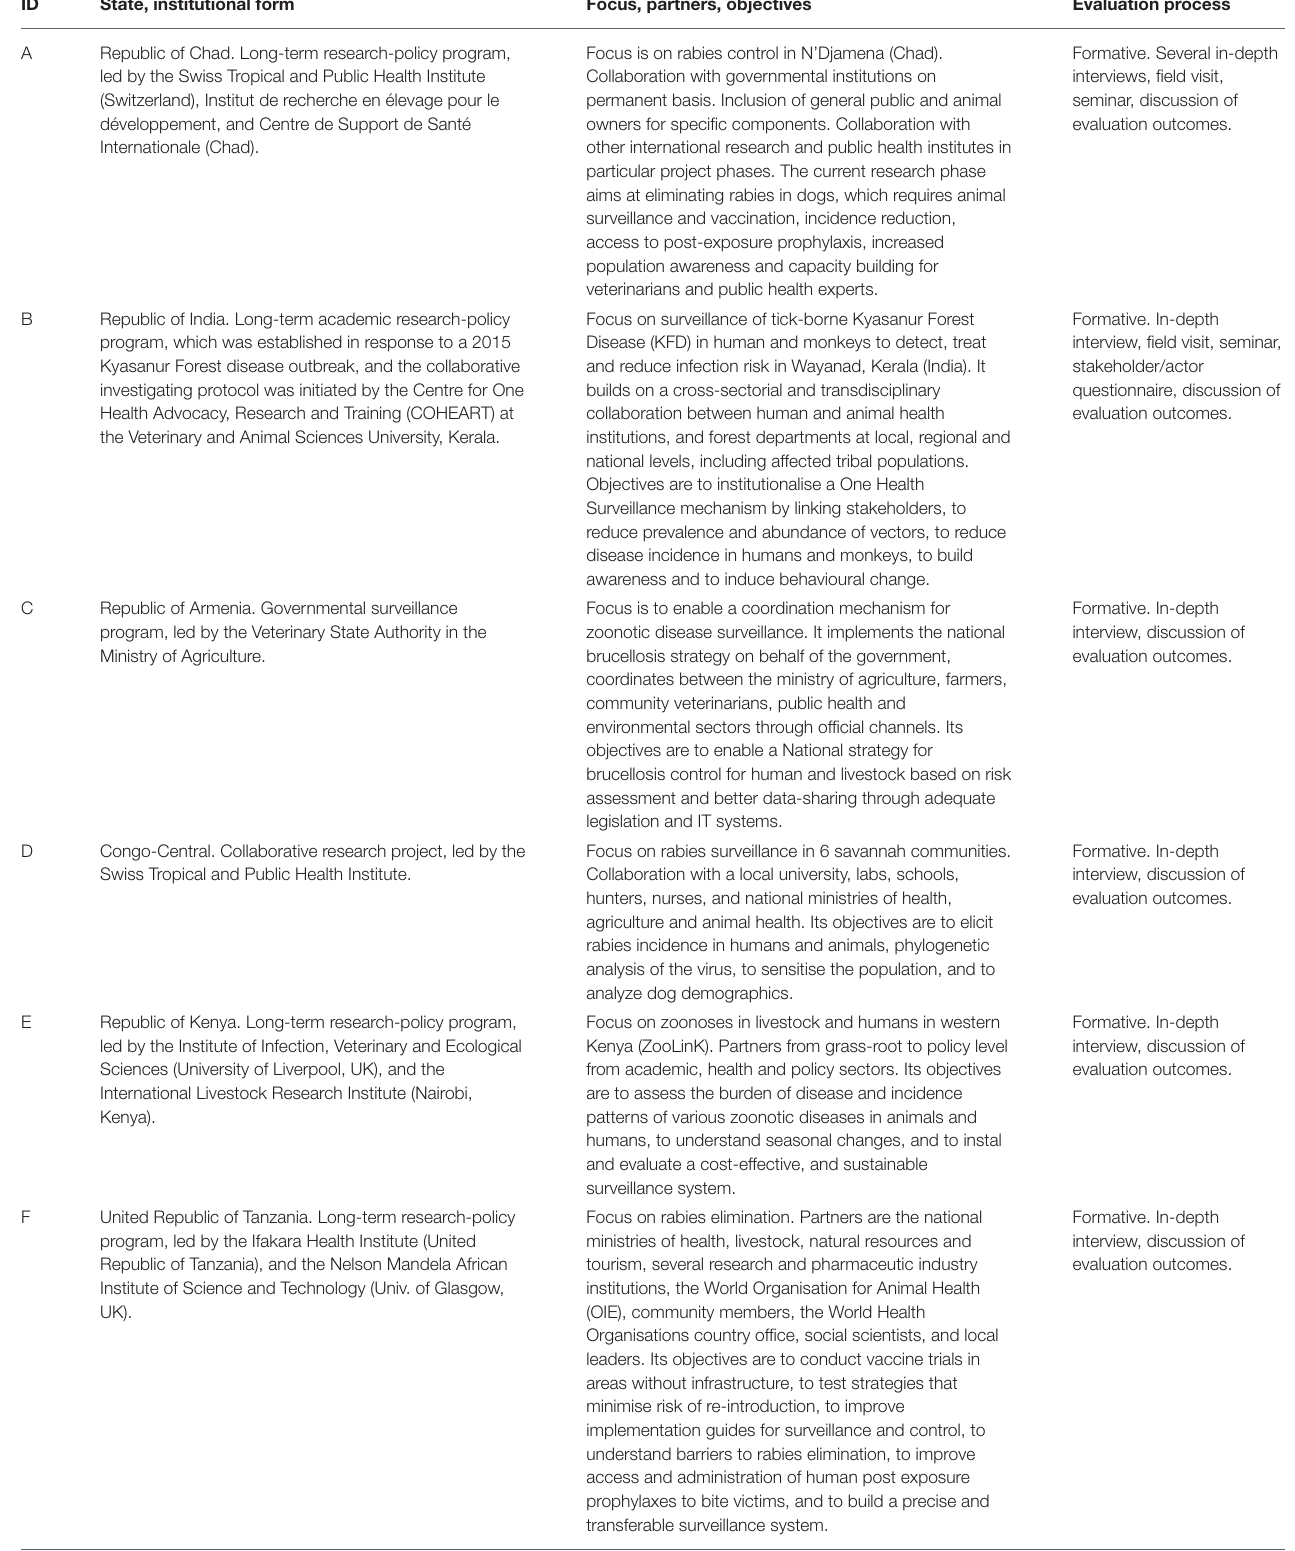
TABLE 2 | Descriptions of initiatives evaluated with the EVOLvINC